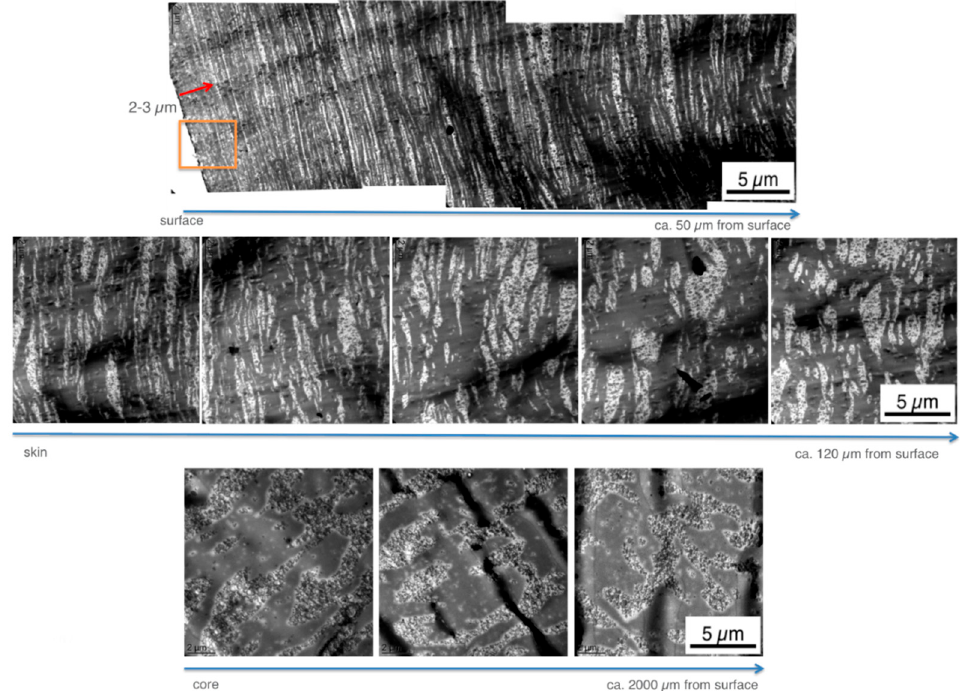
Figure 8. TEM micrographs visualizing the phase morphology profiles within the real surface (first 50 µm layer—upper row), the morphology gradients within the skin layer (first 120 µm from the surface—middle row) and the morphology within the core (bottom row) of an injection-molded specimen made of the PC/ABS blend based on low molecular weight SAN. The orange box in the upper row panorama view illustrates the image detail that is shown at higher magnifications in Figure 8.